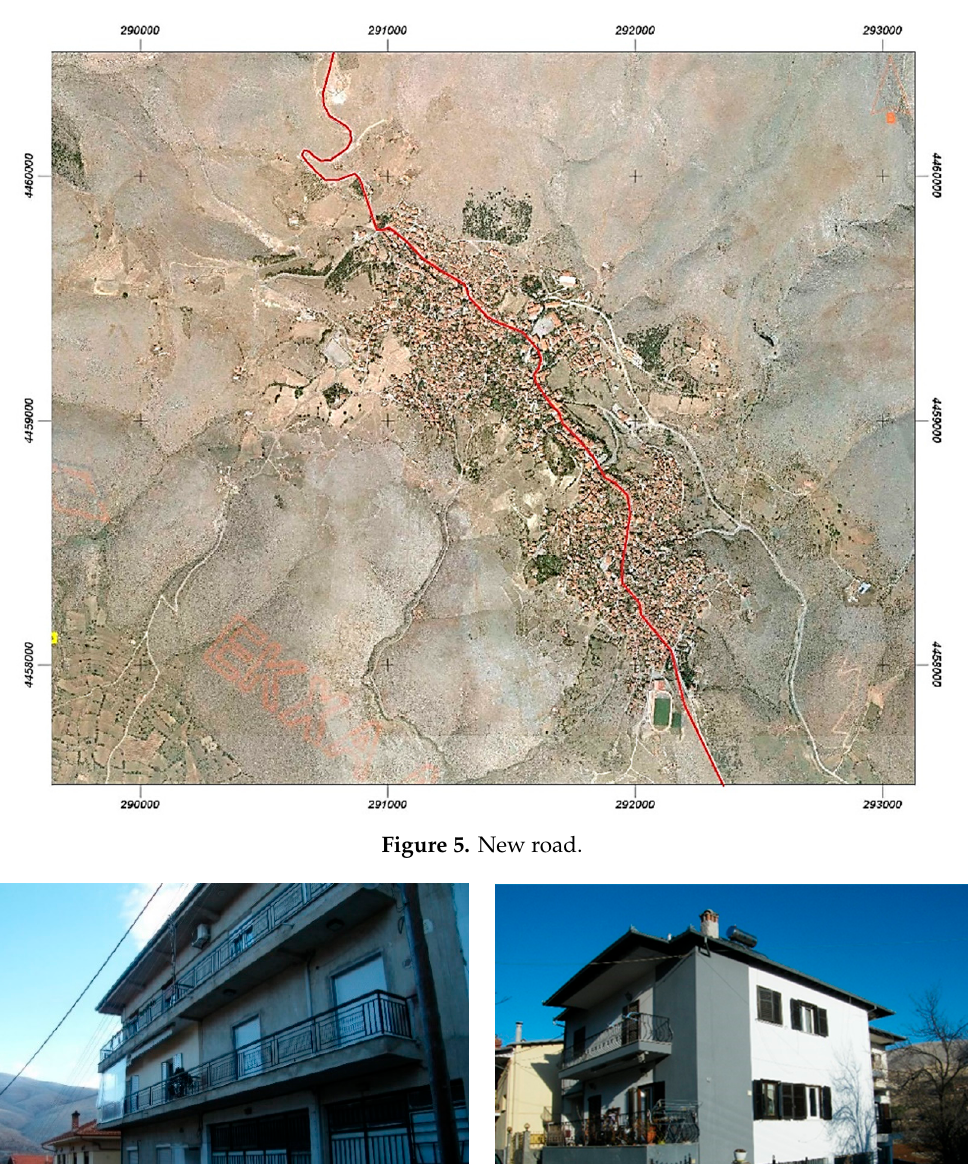
Figure 6. ( a ) Polykatoikia. ( b ) New residences after the morphological regulations.